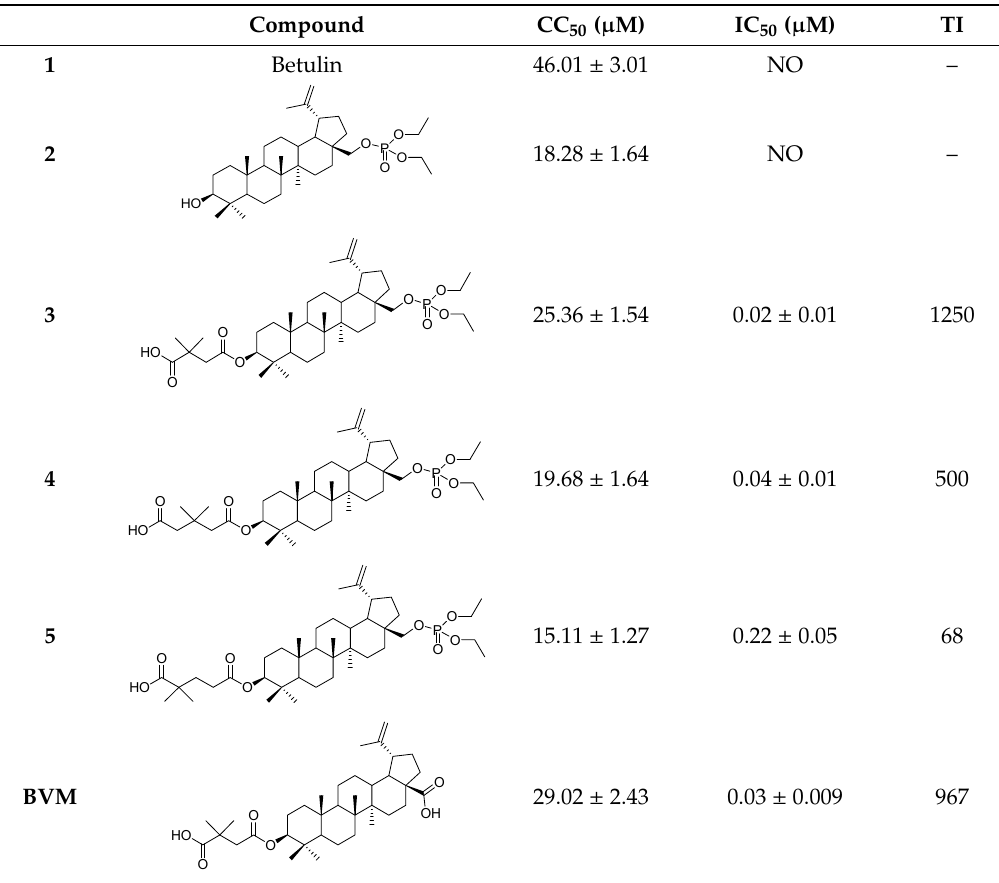
Table 1. Anti-human immunodeficiency virus (HIV)-1 replication activities in human immunodeficiency virus (HIV)-infected CEM-T4 cell line.